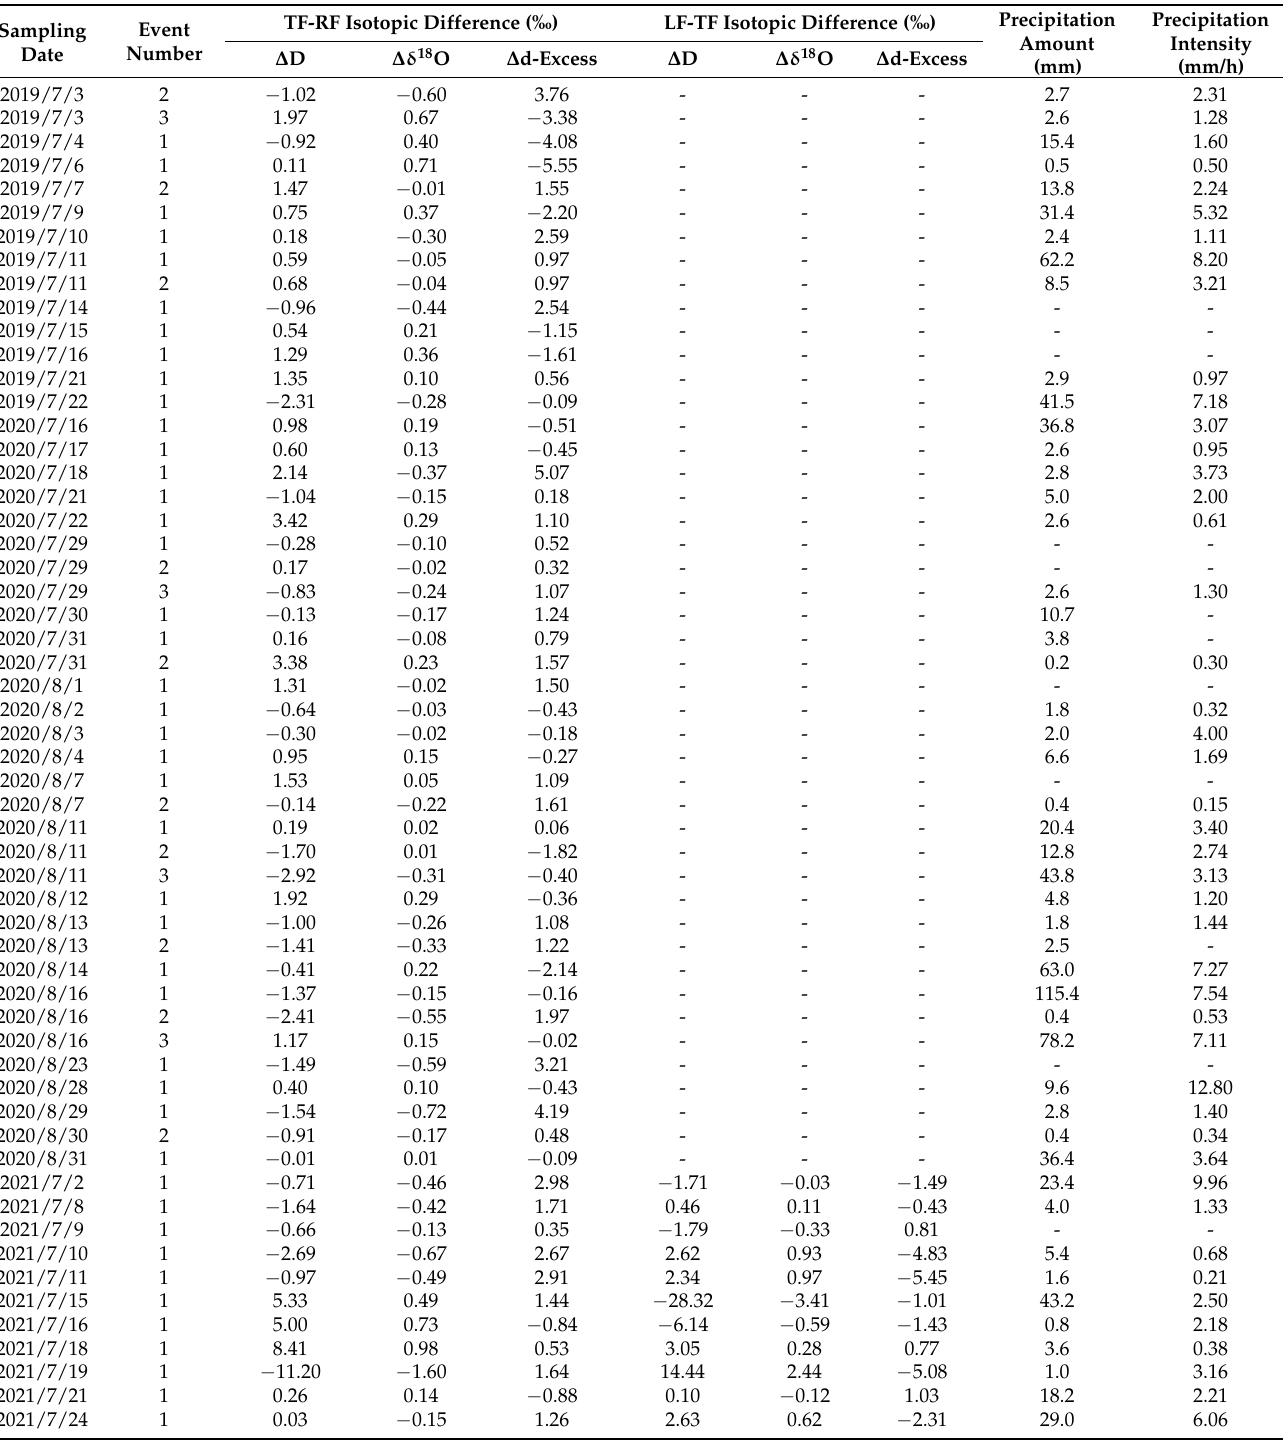
Table 1. Isotopic difference between rainfall (RF), canopy throughfall (TF) and litter layer throughfall (LF) and precipitation amount and intensity of